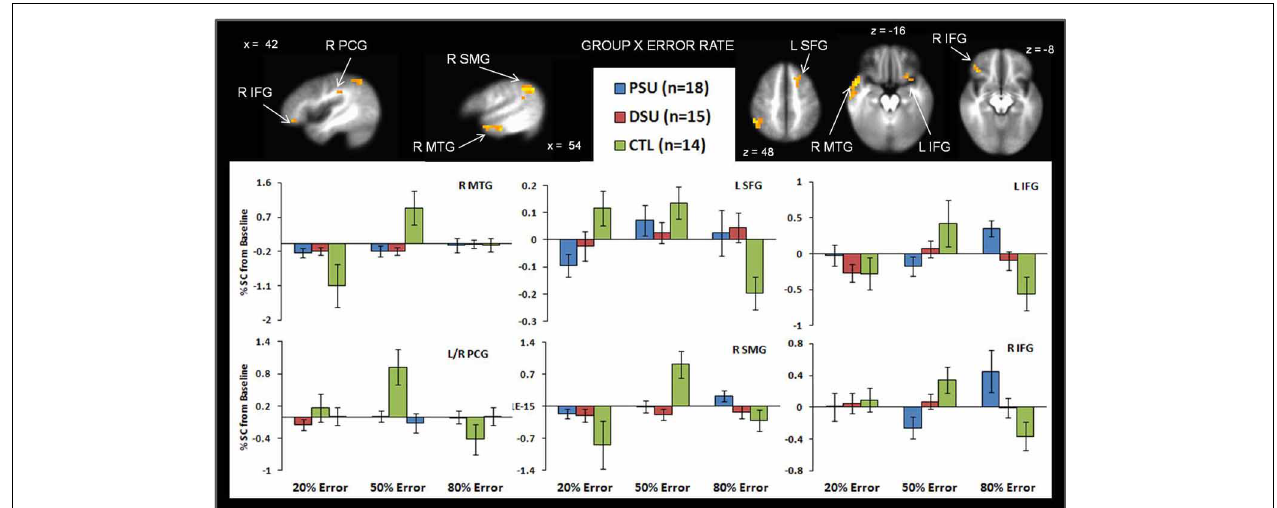
FIGURE 6 | The group by error rate interaction demonstrates that, compared to healthy comparison subjects (CTL), problem stimulant users (PSU) exhibited (1) lower left middle temporal gyrus (MTG) bilateral postcentral gyrus (PCG), and right supramarginal gyrus (SMG) activation in response to uncertainty